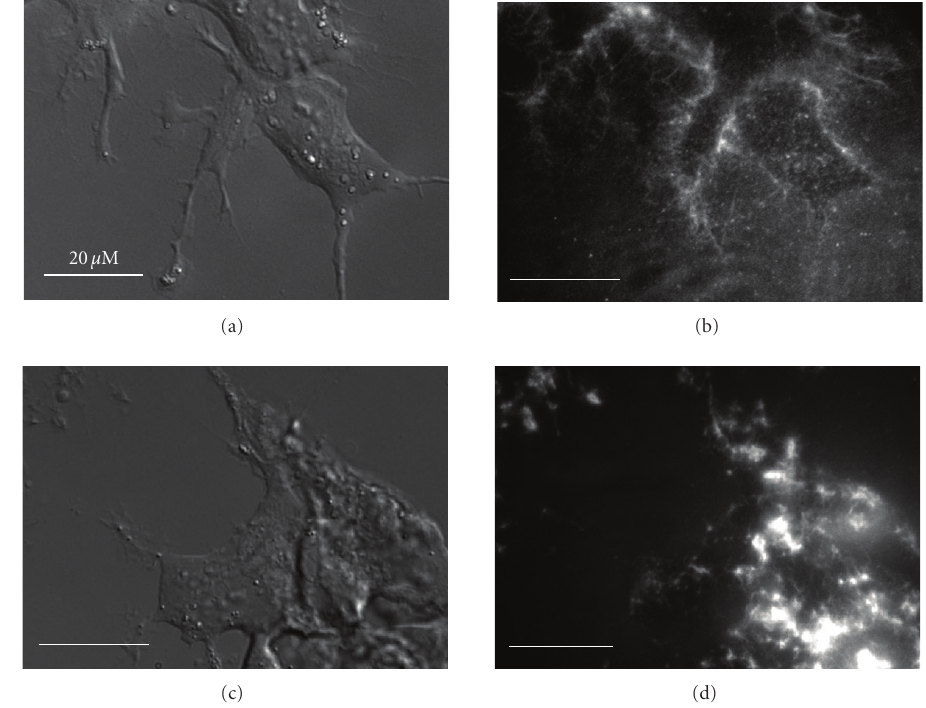
Figure 4: Visualization of amyloid fibrils formed on cell membranes using TIRFM. SH-SY5Y cells were treated with 50 μ M A β -(1–40) ((a), (b)) or 5 μ M A β -(1–42) ((c), (d)) for 48 h. Amyloid fibrils were stained with 20 μ M Congo red. (a) and (c) are DIC images, while (b) and (d) are TIRF images. Data taken from